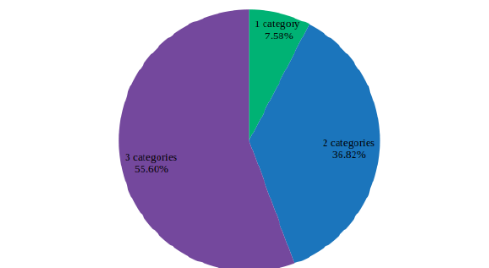
Figure 5. Distribution of the number of categories appeared in TomatOD